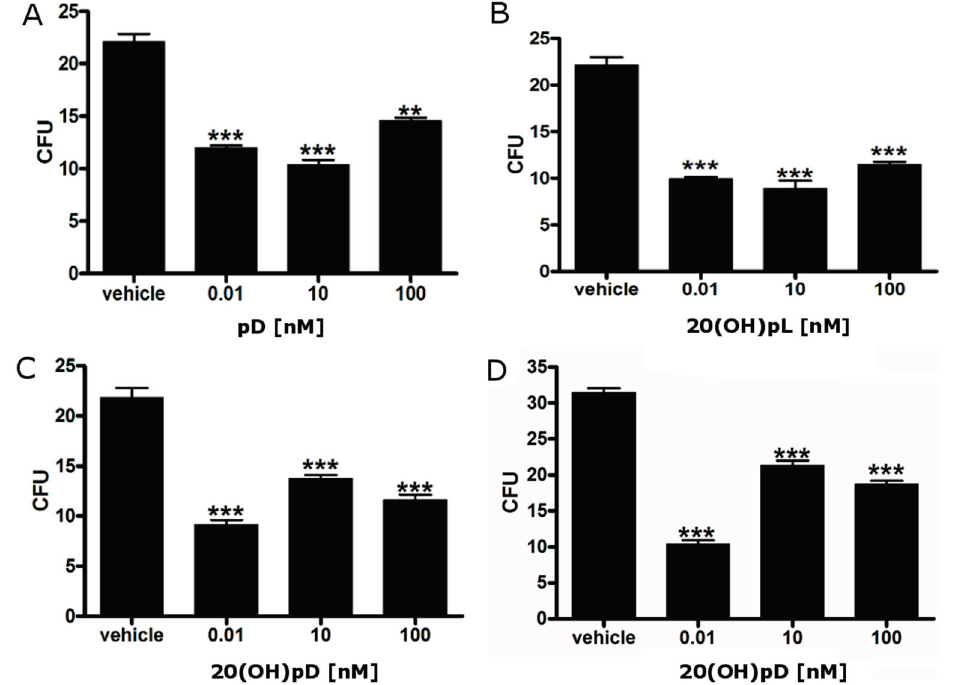
Figure 3. Short side-chain vitamin D analogs inhibit the ability of AbC1 hamster melanoma cells to form colonies in soft agar. Cells were grown in soft agar in the presence or absence of pD ( A ); 20(OH)pL ( B ); or 20(OH)pD ( C , D ). After three weeks, colonies with a diameter larger than 0.2 mm ( C ) or 0.5 mm ( D ) were counted. Data are shown as means ± SD ( n = 4), statistical significance was estimated using t-test and presented as ** p < 0.01, *** p <